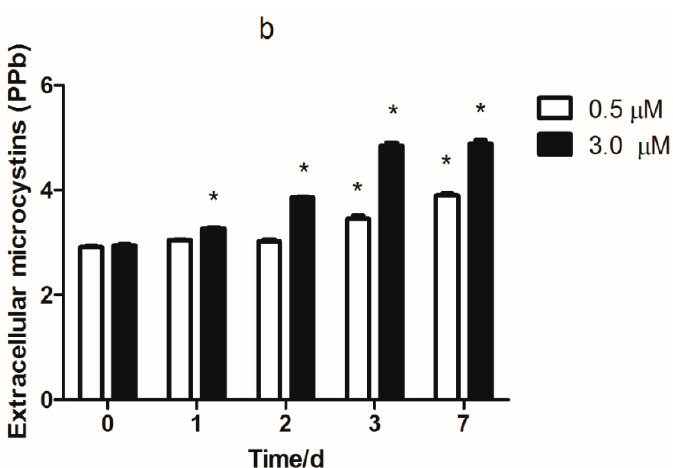
Figure 7. Intracellular and extracellular microcystins under copper stress (PPb). The levels of the intracellular ( a ) and extracellular ( b ) microcystin measurements in M. aeruginosa under conditions of copper excess (0.5 and 3 µM copper) for 1, 2, 3, or 7 days. The experiments were done in triplicate and the average with the standard deviation is plotted. * represents significance at p < 0.05 between copper-treated groups and the control group.